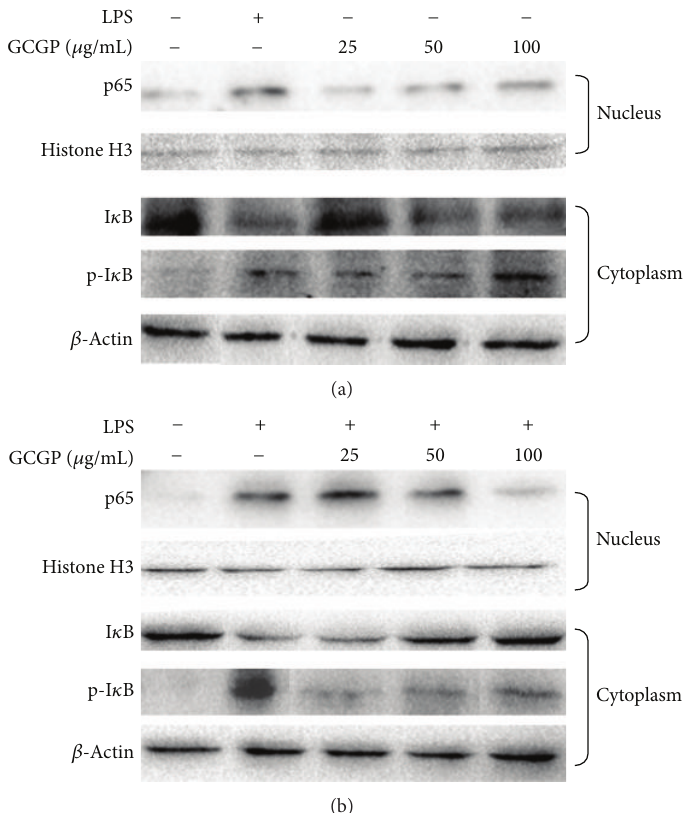
Figure 2: Effects of GCGP on NF- 𝜅 B activity in RAW264.7 cells. (a) GCGP activated NF- 𝜅 B signaling in normal RAW264.7 cells. (b) GCGP inhibited NF- 𝜅 B signaling in LPS-activated RAW264.7